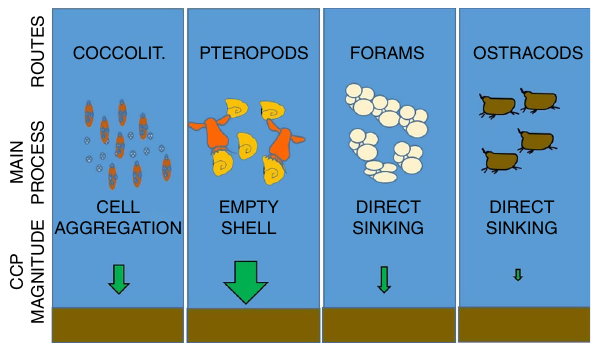
Fig. 5 Dominant process driving the carbonate counter pump. Schematic diagram highlighting the dominant process driving the carbonate counter pump during the different seasons in the Scotia